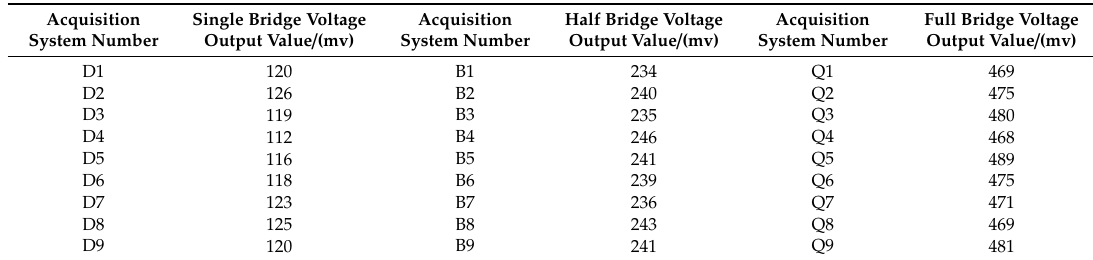
Table 1. Parameters of fog machine system.